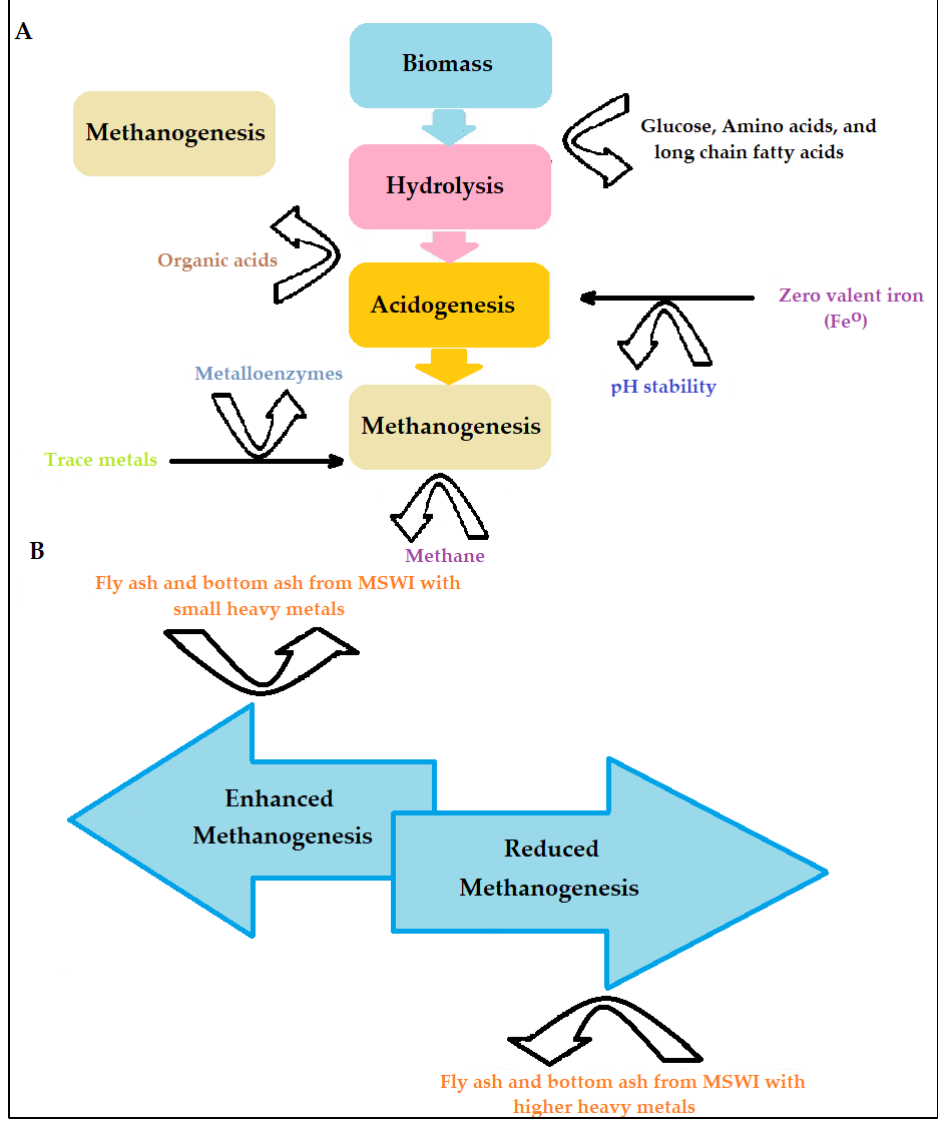
Figure 5. ( A ) Mechanisms of metal-based additives in anaerobic digestion. ( B ) Municipal solid waste incineration ash as additive in anaerobic digestion. Adapted from [40].